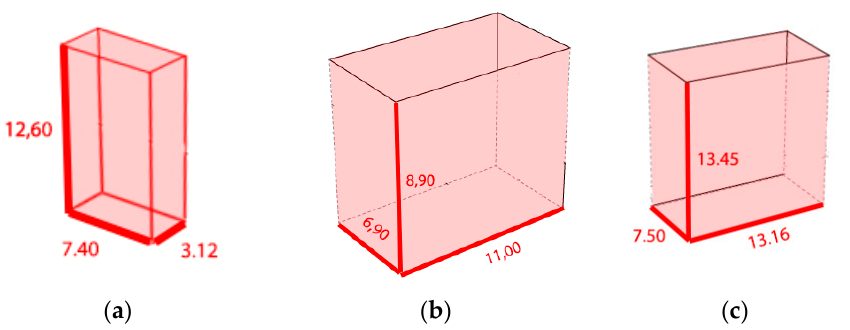
Figure 1. Scheme and dimensions of the studied courtyards. ( a ) Case 1. ( b ) Case 2. ( c ) Case